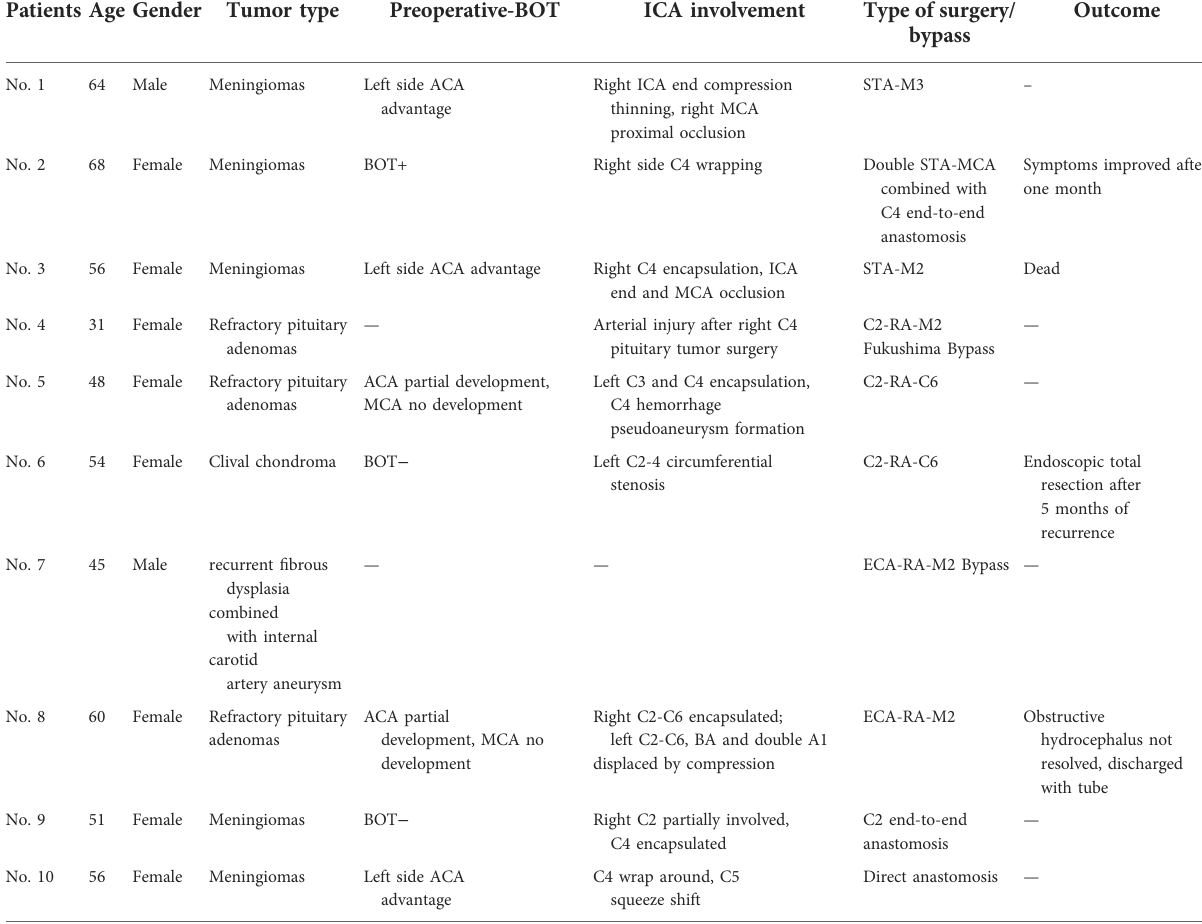
TABLE 1 Basic clinical information of the patients. Patients Age Gender Tumor